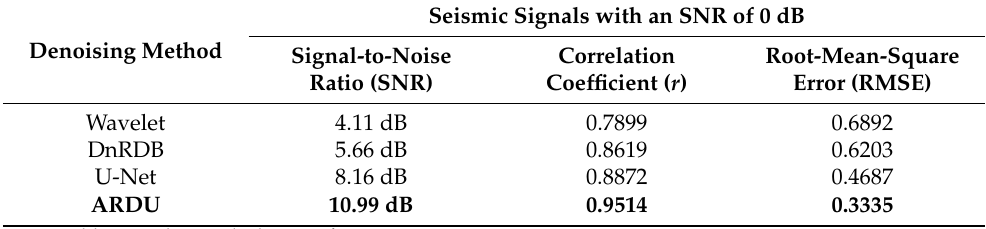
Table 2. Denoising results of seismic signals with an SNR of 0 dB using different methods.